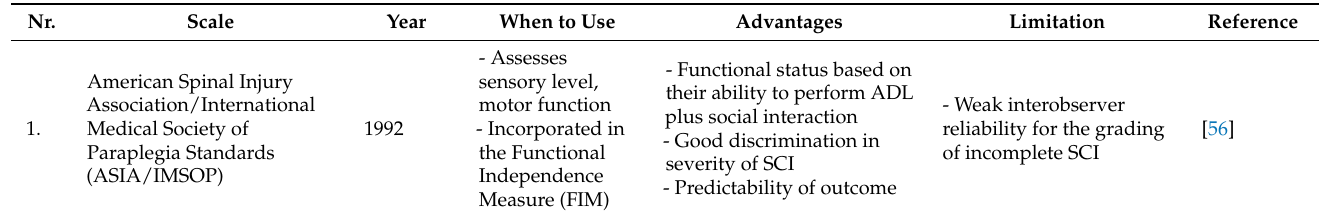
Table 3. Scale for the evaluation of the neurological deficit and functional assessment of patients with